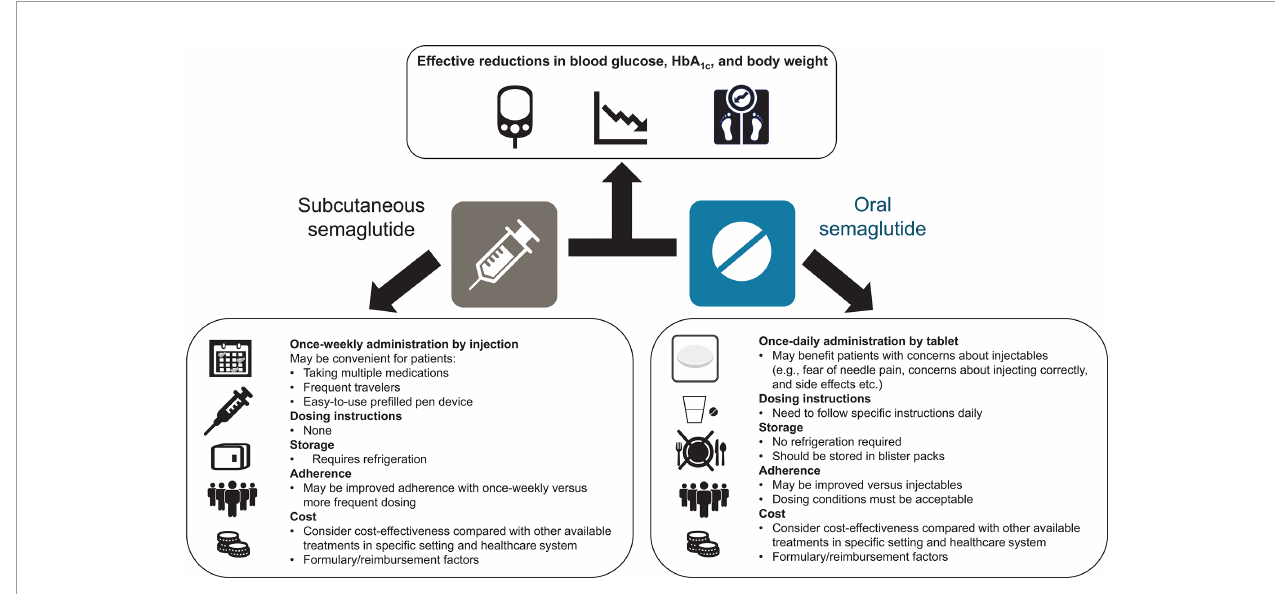
FIGURE 3 | Overview of considerations related to the use of subcutaneous and oral formulations of semaglutide. HbA 1c , glycated